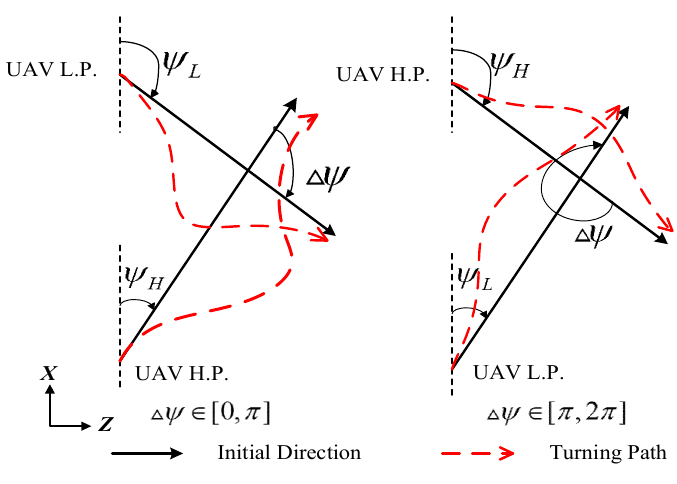
Figure 6. Synergetic heading angle control rule.